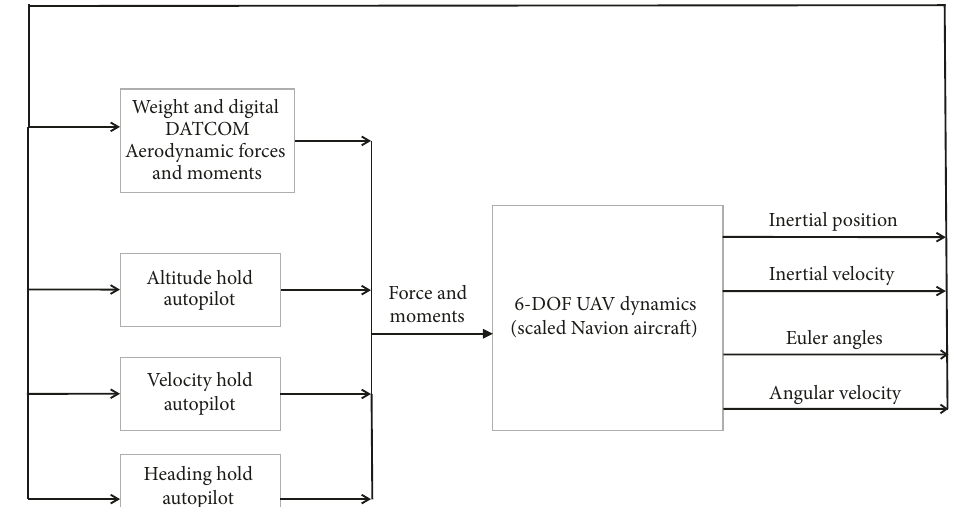
Figure 4: Block diagram of 6-DOF UAV simulation model.